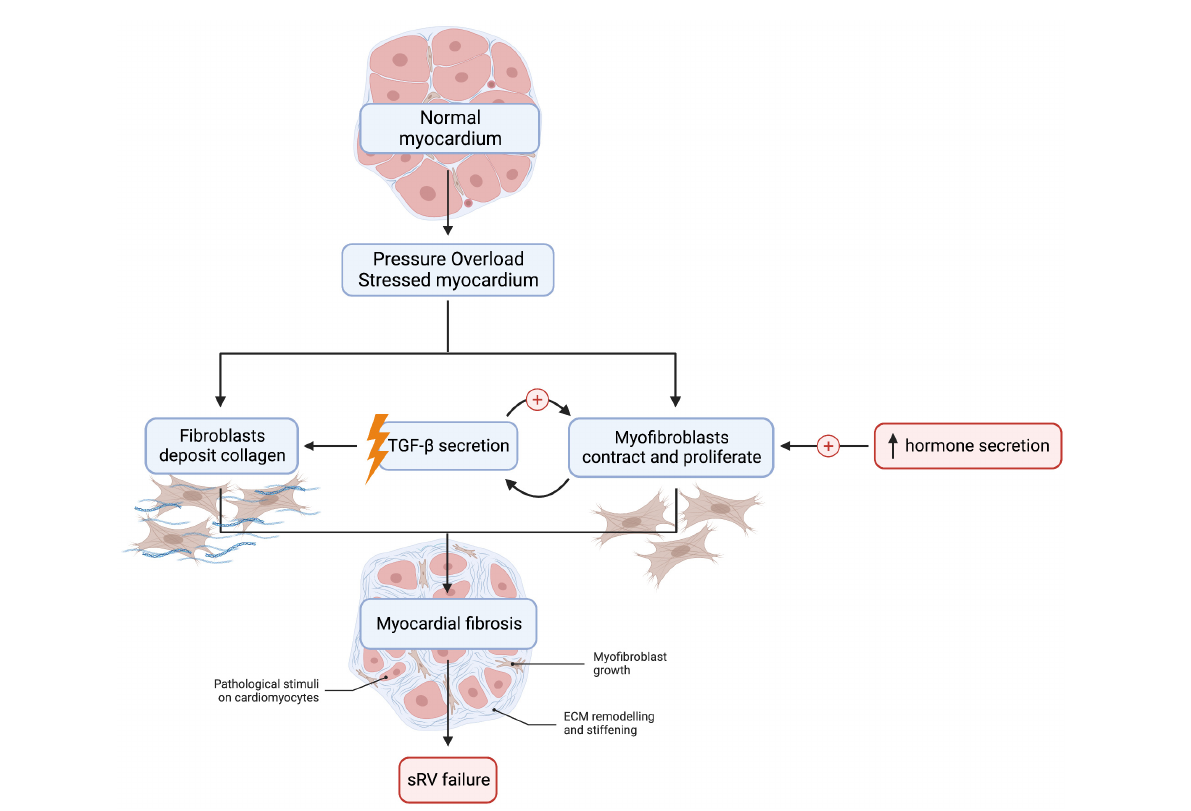
FIGURE2 Myocardial fibrosis is detected in many sRV patients and increases the risk of adverse cardiac outcomes such as heart failure. Cardiac fibroblast and myofibroblast activation is an essential mediator of fibrosis in left ventricular fibrosis, but this remains to be demonstrated in sRV. TGF- β secretion by myofibroblasts sets up a positive feedback loop that promotes tissue fibrosis. Abnormalities in MMP:TIMP ratio may also result in dysregulated collagen turnover. Lastly, neurohormonal activation is detected in sRV patients: aldosterone, angiotensin II, epinephrine, and norepinephrine are elevated in sRV patients and stimulate collagen production in the myocardium. However, clinical trials thus far have failed to show a beneficial effect of inhibiting the sympathetic and RAAS systems in sRV patients. We created the figure with